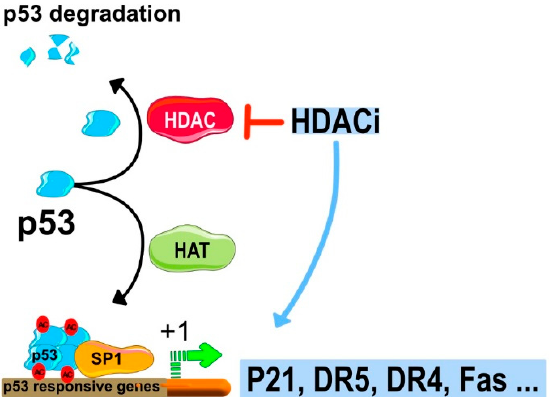
Figure 6. Schematic representation of the molecular mechanism of HDCAIs-induced cell cycle arrest and induction of apoptotic cell death. P21 gene promoter Sp1 can bind HDAC multi protein complex repressing gene transcription. Inhibition of HDAC activates transcription of p21 that stimulates cell cycle arrest. HDACIs can also induce apoptosis via stimulation of tumor necrosis factor (TNF) protein members like TRAIL and CD95.